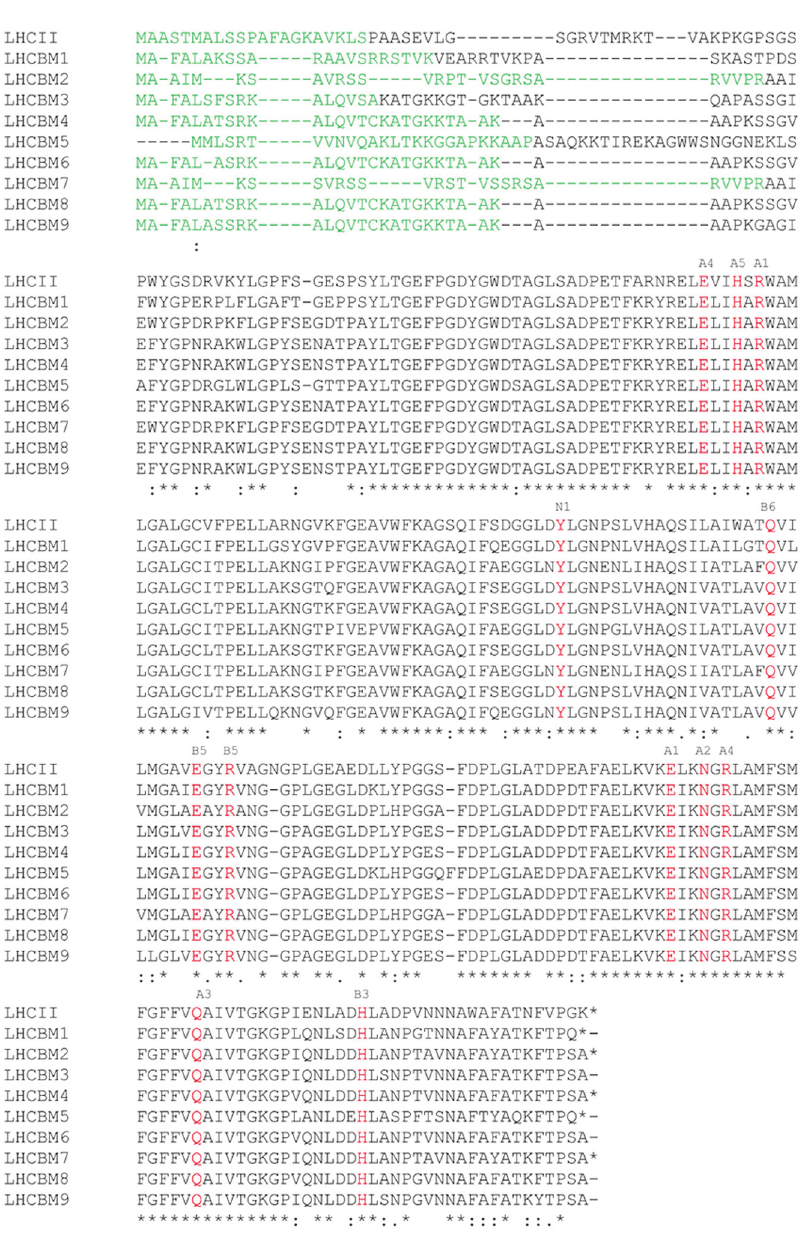
Fig 1. In silico analysis of LHCBM proteins. Multiple sequence alignment of C . reinhardtii LHCBM proteins (Clustal OMEGA). Red-colored amino acids indicate the conserved Chl a and Chl b binding sites and the neoxanthin binding site (tyrosine, N1) [36]; green colored amino acids indicate the transit peptide; blue colored amino acids indicate the region of the trimerization motif.